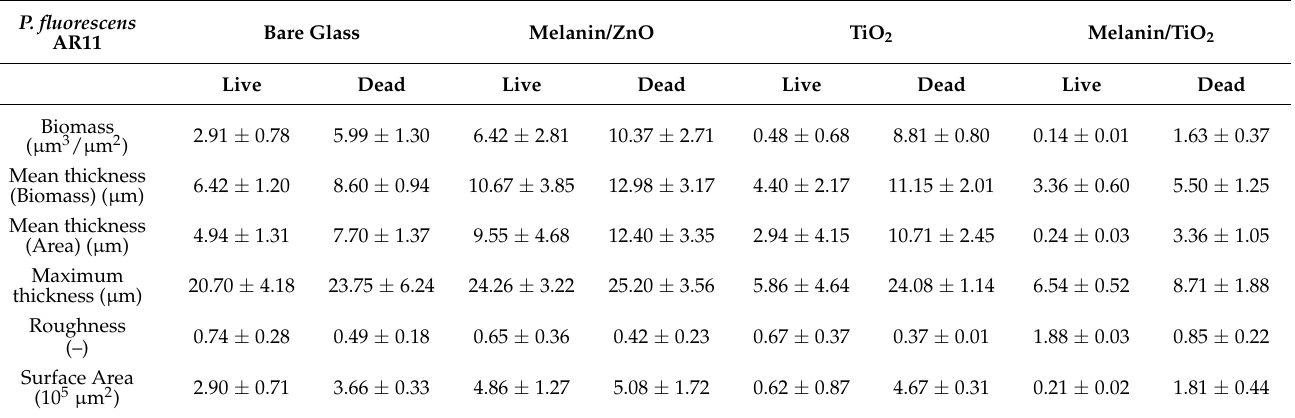
Table 1. Biomass, maximum thickness, mean thickness, roughness, and surface area of biofilm growth on different samples. Analysis was performed using COMSTAT. Values are mean ± standard deviation of data from 3 separate experiments. For each experiment, 9 image stacks were